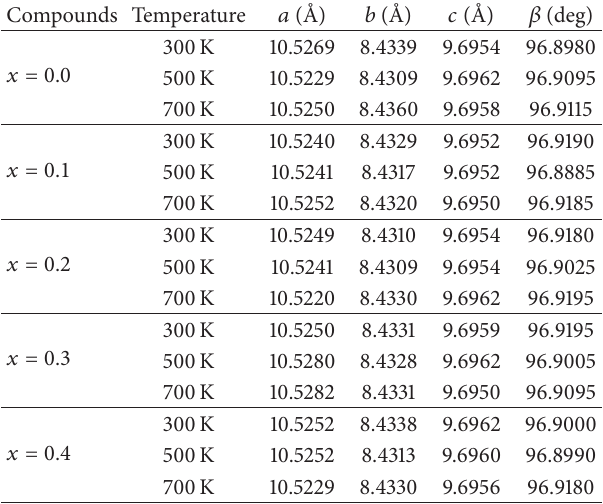
Table 4: The cell constants of Tb temperatures. Compounds